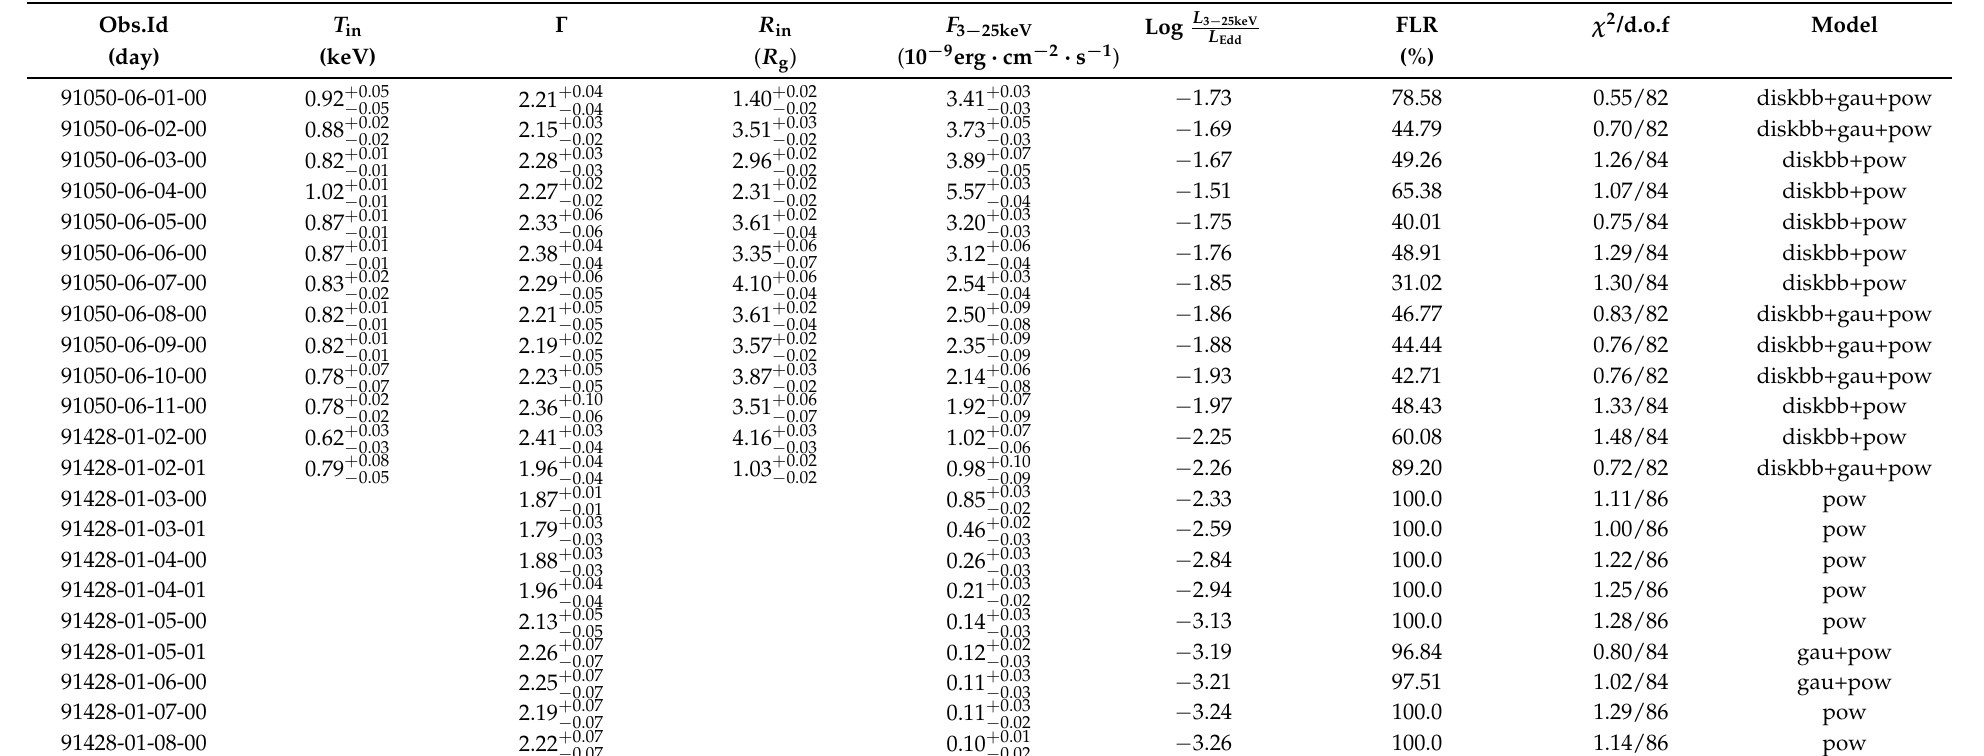
Table 1. The best fitting parameters of the spectra of H1743-322 during the “faint” 2005